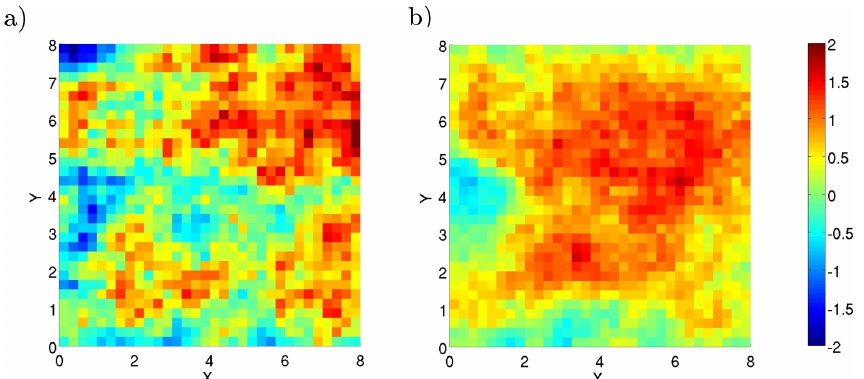
Fig. 5. Scenario 2: log-transformed hydraulic conductivity field retrieved by (a) the EnKF and (b) ES using log-transformed concentration data. The color bar indicates log-transformed hydraulic conductivity in ln (L/T ) .